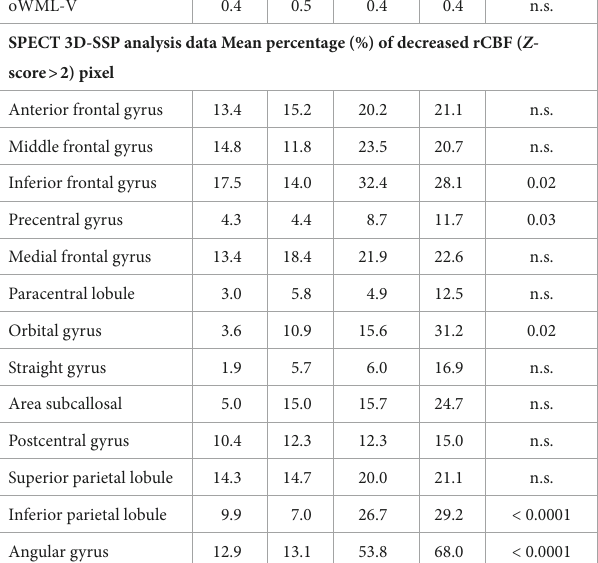
thalamus (Table 1). The mean percentage of pixels with decreased rCBF (Z-score > 2) in the ESCI group is shown in the colored figure (Figure 2). The anterior cingulate gyrus and angular gyrus had more than 50% of pixels with decreased rCBF, followed by the superior temporal gyrus.